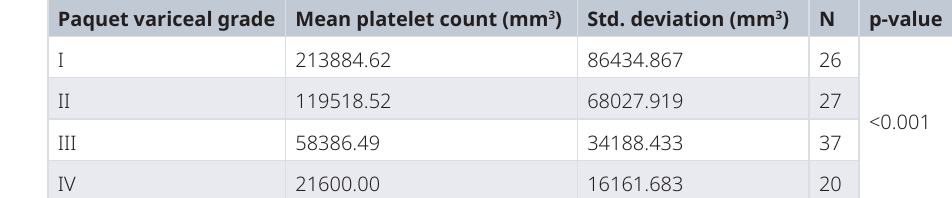
Table 3. Association of mean platelet count with Paquet variceal